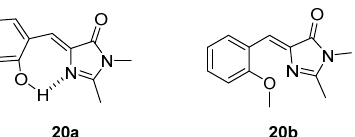
Figure 20. GFPc analogues demonstrating that the intramolecular hydrogen bond increases the emission intensity in solution [35].